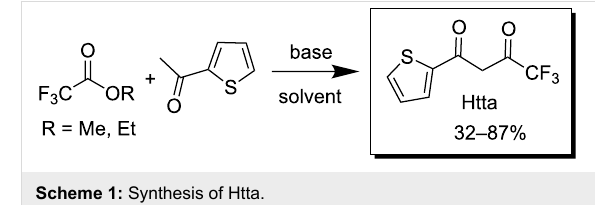
Figure 1: Known thiophene-based perfluorinated β -diketones.